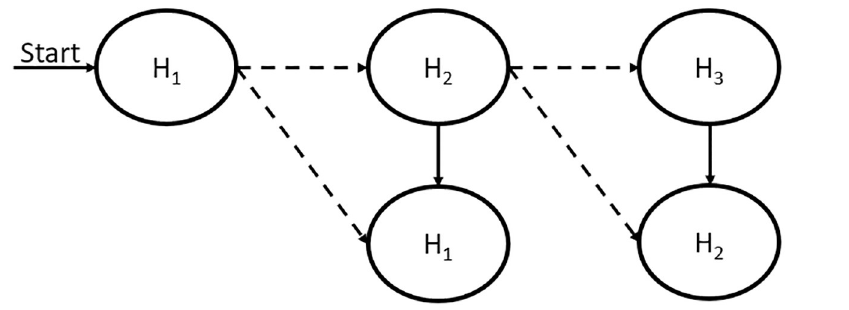
Fig 15. Proposed progressive mobility prediction.